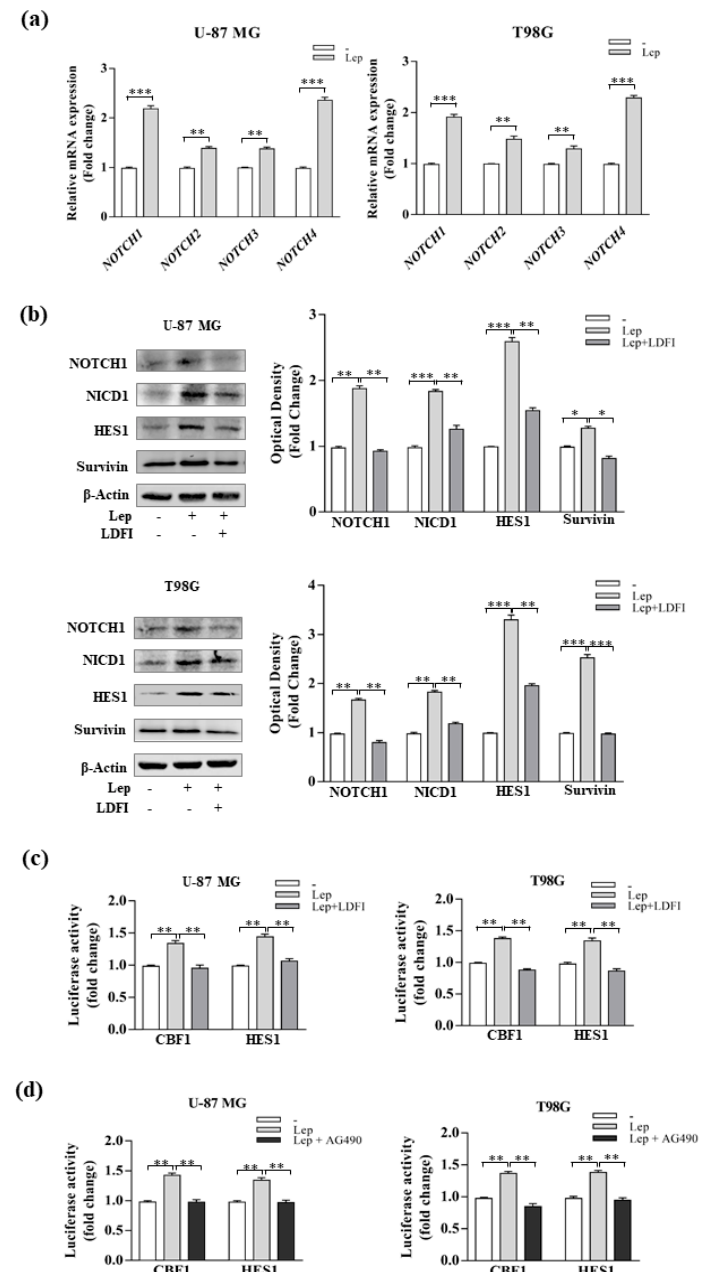
Figure 5. Leptin induces the expression of NOTCH and its molecular targets in glioblastoma cells. ( a ) Real-time RT-PCR for NOTCH1, NOTCH2, NOTCH3, and NOTCH4 receptors in U-87 MG and T98G cells treated for 12 h with vehicle (-) or 500 ng / mL leptin (Lep). ( b ) Expression levels of NOTCH1, NICD1, HES1, and Survivin, in U-87 MG and T98G cells treated with vehicle (-) and leptin (Lep, 500 ng / mL) alone or in combination with LDFI, 1 µ mol / L for 12 h. β -Actin was used as a loading control. The histograms represent the means ± SD of three separate experiments in which band intensities were evaluated in terms of optical density arbitrary units and expressed as a fold change vs. vehicle-treated samples, which were assumed to be 1. U-87 MG and T98G cells transiently transfected with CBF1-Luc or HES1-Luc reporter constructs. After transfection, cells were treated with vehicle (-), and leptin (Lep, 500 ng / mL) alone or in combination with LDFI, 1 µ mol / L ( c ), or treated with vehicle (-), and leptin (Lep, 500 ng / mL) alone or in combination with AG490, 20 µ mol / L for 12 h ( d ). The histograms represent the means ± SD of three separate experiments, each performed in triplicate. * p < 0.05, ** p < 0.01, and *** p <